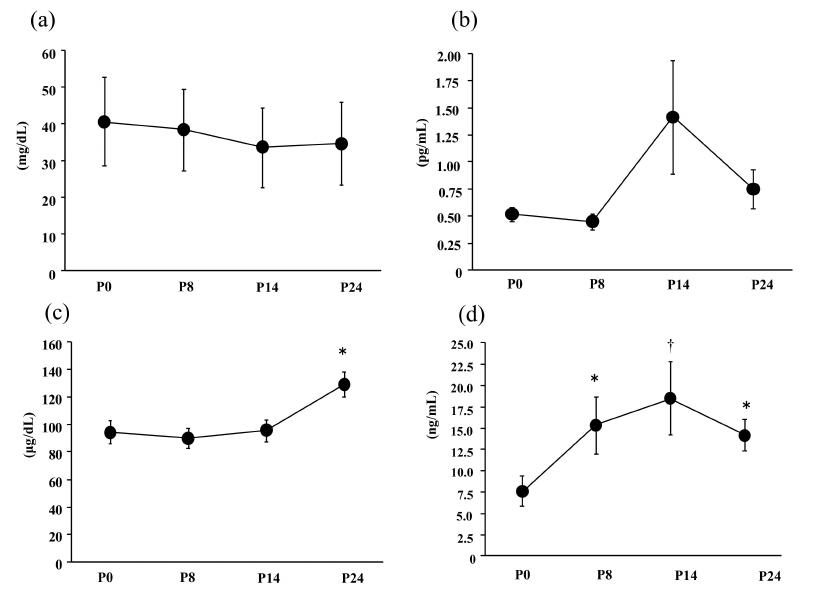
Figure 2. Comparisons of blood variables. ( a ) Serum haptoglobin level, ( b ) plasma IL-6 level, ( c ) serum iron level, and ( d ) serum hepcidin level. The values are means ± SE. * Significant difference from P0 ( p < 0.05), † Significant difference from P0 ( p <